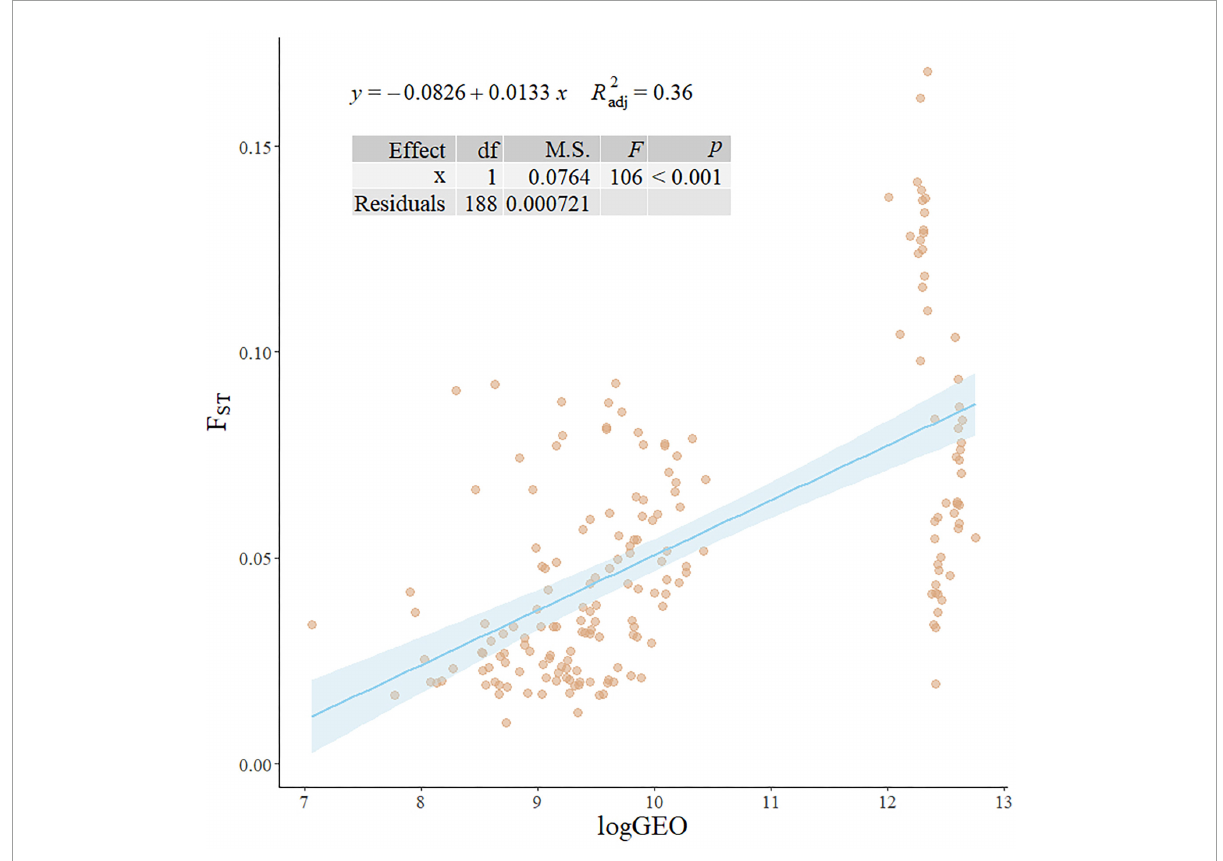
FIGURE3 The linear regression model between log-transformed geographic distance and F ST .